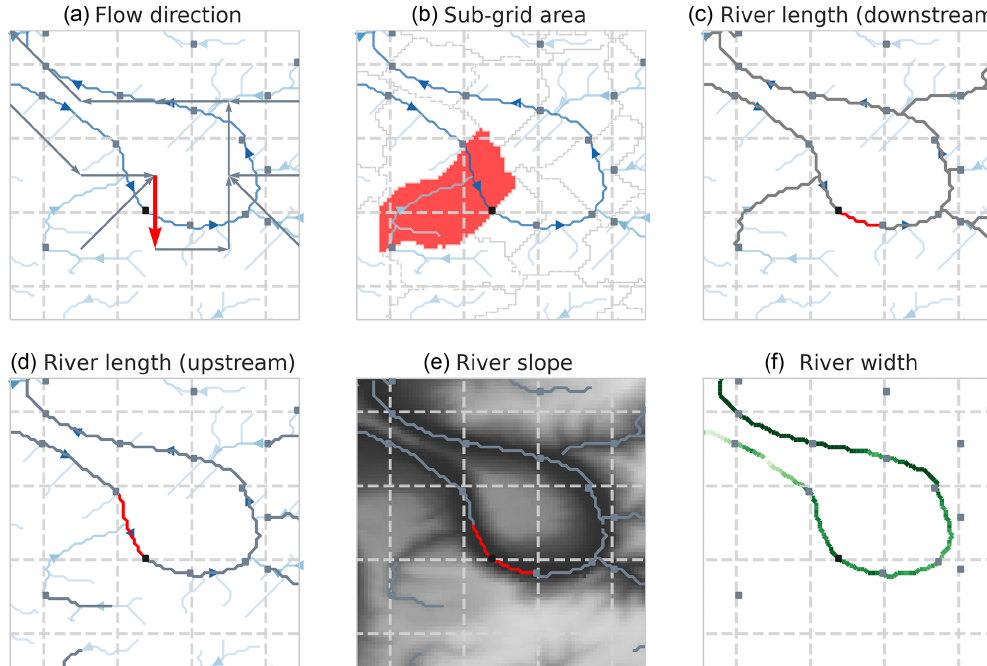
Figure 2. Output hydrography variables based on fine-resolution flow directions (blue lines in a – d ; darker indicates larger upstream area) and/or outlet pixels (squares). Each variable is highlighted in red for the center cell and grey for other cells. The sub-grid area (b) is based on all pixels draining to the outlet pixel and limited by upstream outlet pixels. River length is derived based on the length of the flow path from outlet pixel to next downstream (c) or upstream (d) outlet pixel. The River slope (e) is calculated as the elevation (grey colors) difference over a flow path from a set length upstream to downstream of the outlet pixel. The river width (f) is derived based on the sub-grid river width (green colors) at the outlet pixel